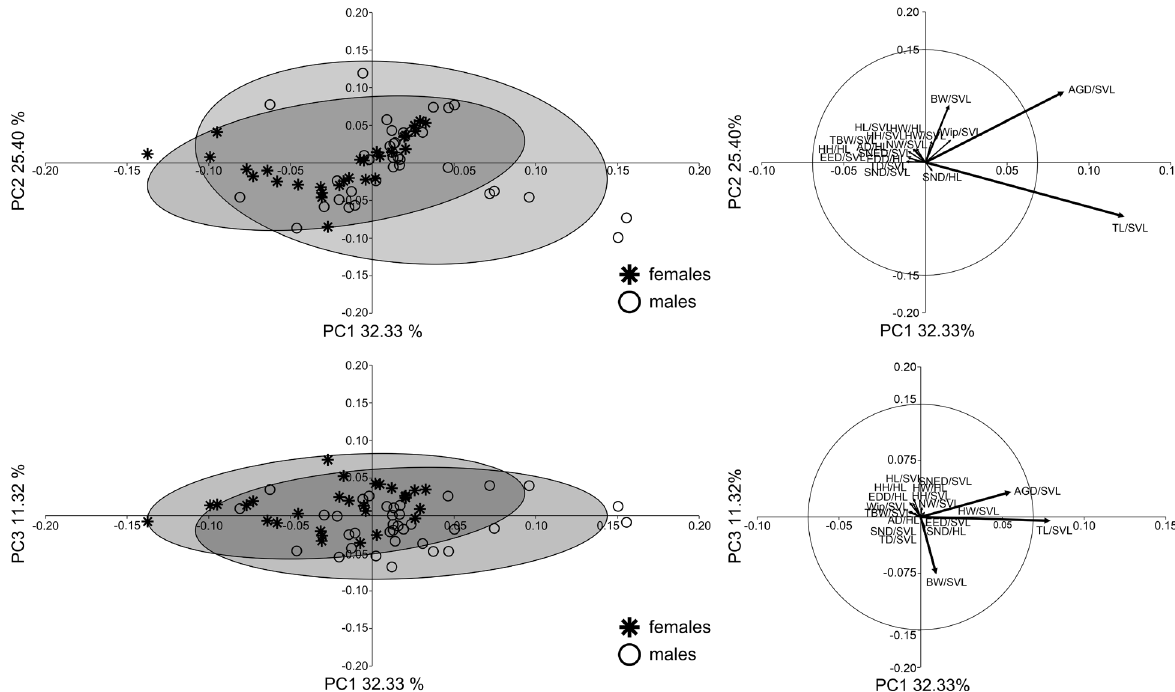
Figure 2. Results of PCA (Principal Component Analysis) on body shape variables: HL/SVL; HW/SVL; HH/SVL; NW/ SVL; SNED/SVL; SND/SVL; EED/SVL; AGD/SVL; BW/SVL; TBW/SVL; AD/SVL; TD/SVL; HipW/SVL; TL/SVL; HW/HL; HH/HL; SND/HL; EED/HL between females (asterisk symbol) and males (empty dots) of Phymaturus extrilidus . Morphospace plotted on PC1vs. PC2 and PC1 vs. PC3, corresponding to the percentage of the total variance explained by each axis. Biplot (right panel) correspond to the contribution of each variable to the reconstruction of the axes on PC1 vs. PC2 and PC1 vs. PC3. Significant variables are indicated with thickened